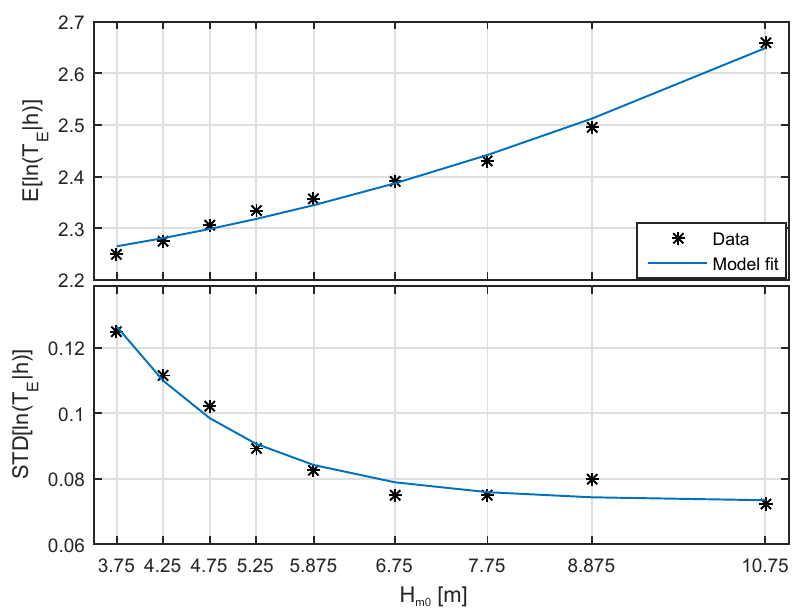
Figure 4. Fit of log-normal parameters for conditional probability distributions of T E (conditional on H m 0